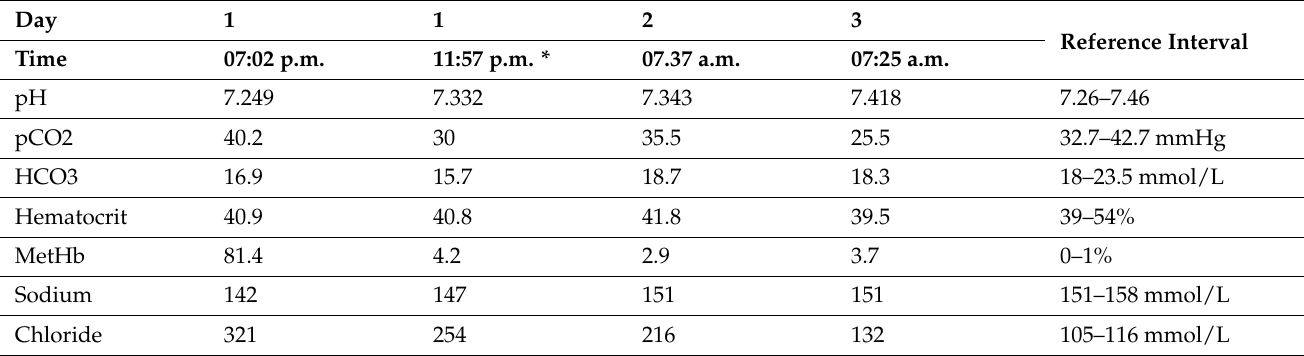
Table 1. Serial blood gas analyses prior and after administration of methylene